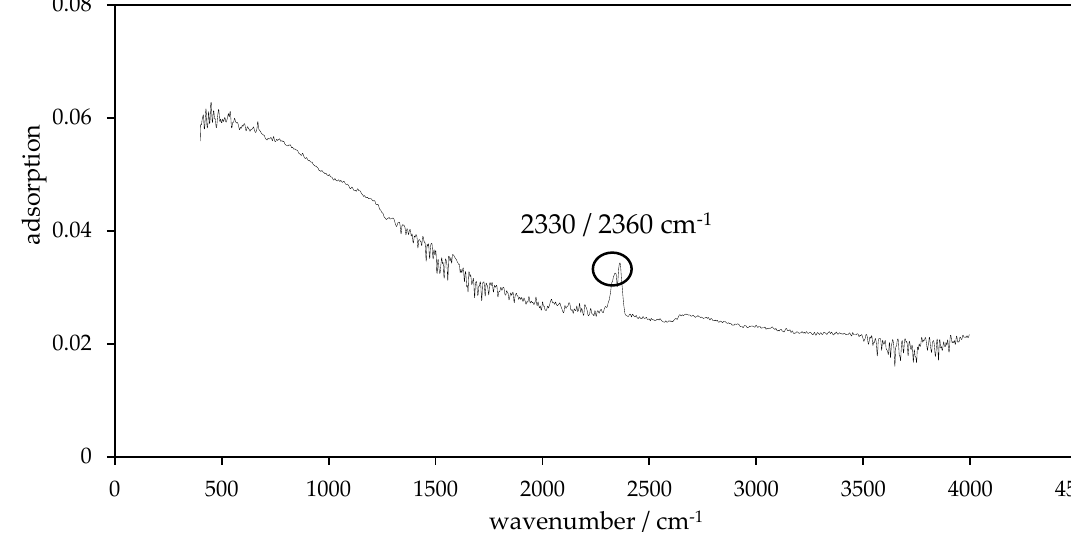
18 of 30 Figure 9. Fourier transform infrared spectroscopy (FTIR) spectrum of hydrochar HTC-220-5. Concerning PHC900 samples (Figure 10), from the wave number 1700 cm −1 to 2230 cm −1 , many small peaks are closely lined up, which are not included in the discussion. These peaks can only be